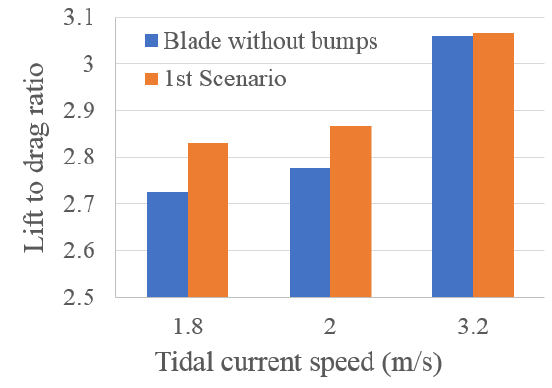
Figure 12. Influences of the bumps on 𝐹 𝐿 𝐹 𝐷 ⁄ at tidal current speeds.